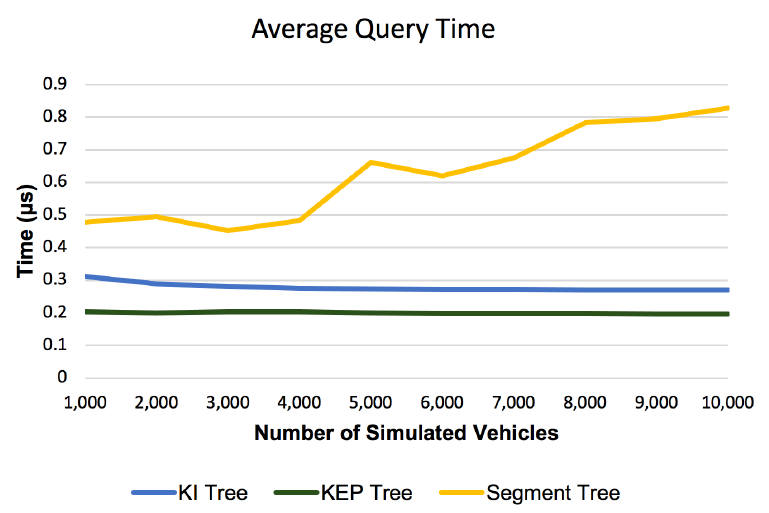
Figure 15. Average Query Time for Segment, KI and KEP Trees.